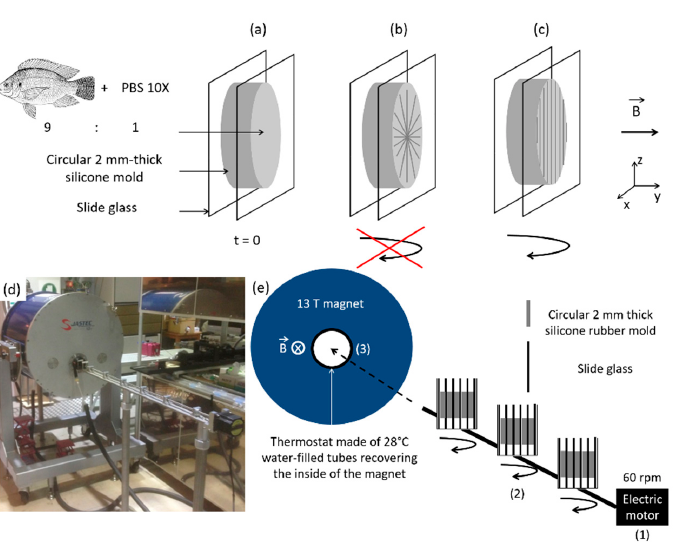
Figure 2. ( a ) Magnetic field application in a collagen gel. ( b ) Under a high magnetic field along y